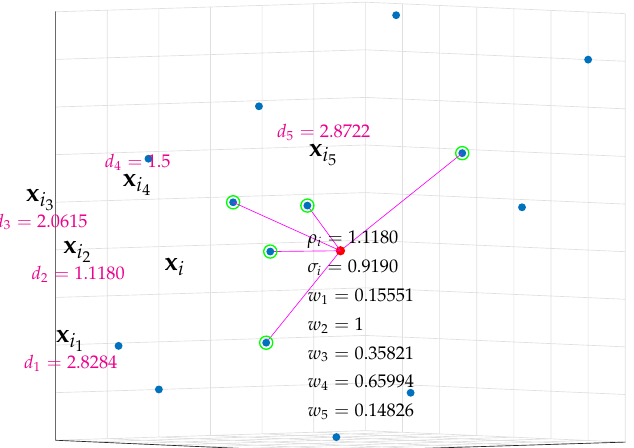
Figure A1. Five nearest neighbors of point x i for a particular set of points in R 3 , where, for simplicity, d j = d ( x i , x i